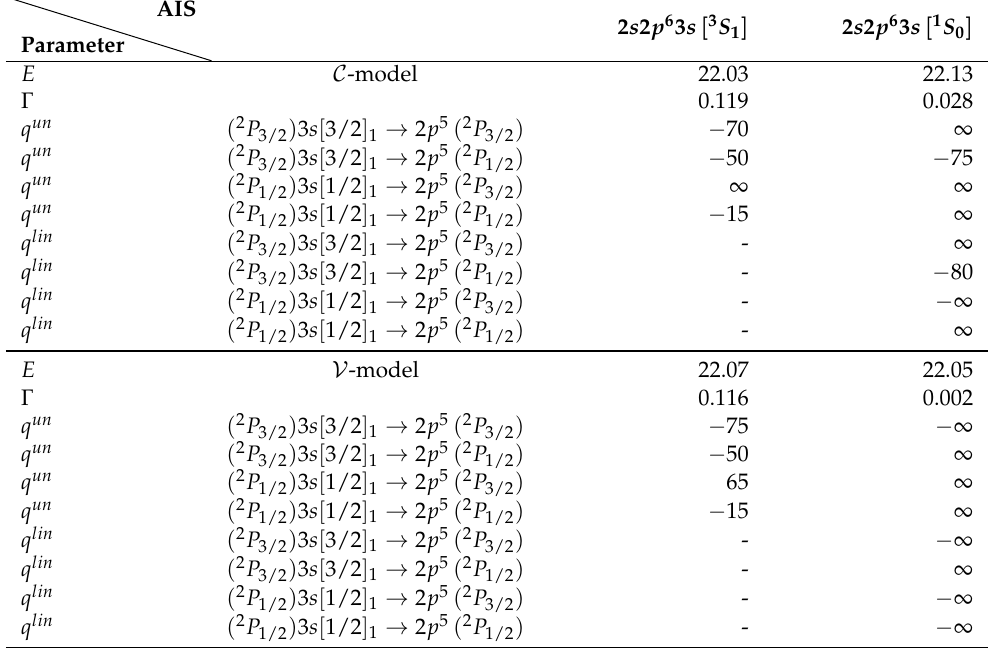
Figure 5. Cross-section calculated in the length gauge within the V - (dash-dotted lines) and C - (solid lines) models with six (cyan and blue) and ten (orange and red) thresholds for ion- ization of 2 s 2 2 p 5 ( 2 P 1/2 ) 3 s [ 1/2 ] 0 ( a , e ), 2 s 2 2 p 5 ( 2 P 3/2 ) 3 s [ 3/2 ] 2 ( b , f ) and 2 s 2 2 p 5 ( 2 P 3/2 ) 3 s [ 3/2 ] 1 ( c , g ), 2 s 2 2 p 5 ( 2 P 1/2 ) 3 s [ 1/2 ] 1 ( d , h ) states to 2 s 2 2 p 5 ( 2 P 3/2 ) (upper row) and to 2 s 2 2 p 5 ( 2 P 1/2 ) (bottom row) ionic states for unpolarized fields. The arrows mark positions of very narrow resonances 2 p 4 3 s 2 [ 2 P J = 1,2 ] where they would appear within the LSJ -coupling scheme. Table 2. AISs parameters in a model within ten target states: energy position E (eV), width Γ (eV) and Fano profile index q at excitation of different initial states for different